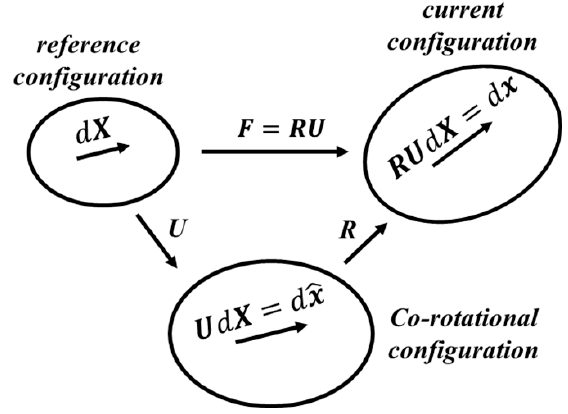
Figure 4. Schematic of the co-rotational formulation.